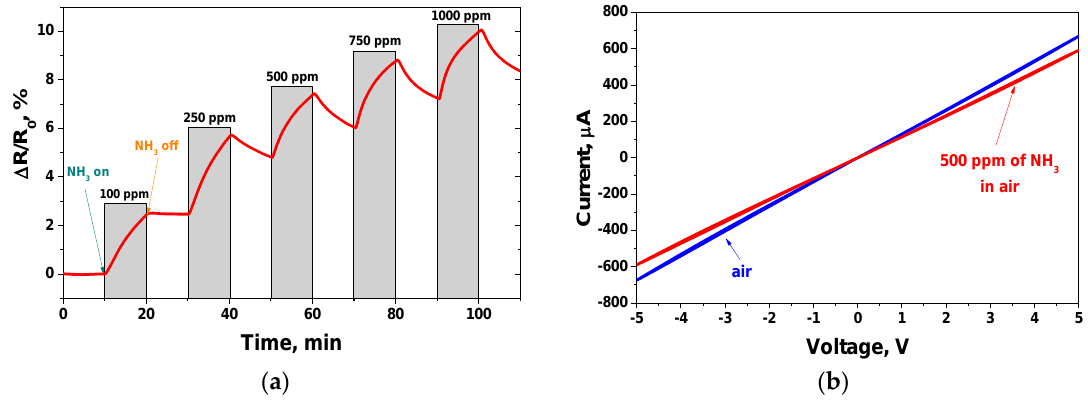
Figure 4. GO-based chemiresistive sensor measurements at room temperature: ( a ) response to ammonia in the range of concentrations from 100 ppm to 1000 ppm; ( b ) current-voltage characteristic measured in air atmosphere (red curve) and in 500 ppm of ammonia in air mixture (blue curve).